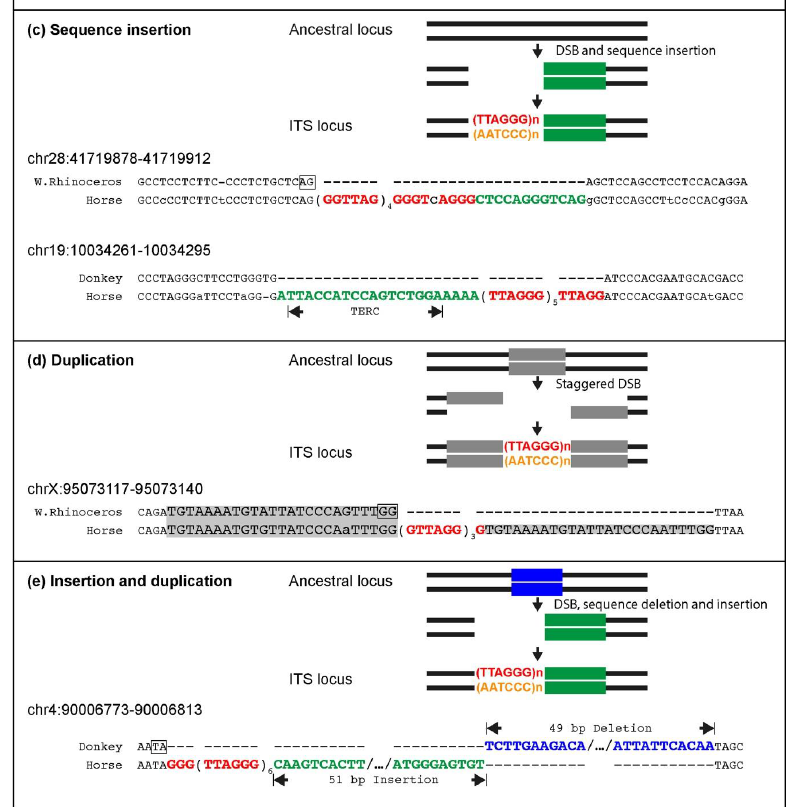
Figure 3. Examples of data used to describe the insertion mechanism of telomeric repeats. For each locus, the alignment of the empty ancestral sequence from donkey or white rhinoceros with the ITS sequence in the horse reference genome assembly is shown. A sketch of the mechanism responsible for telomeric repeat insertion is shown on top of each sequence alignment. Telomeric repeats in TTAGGG and CCCTAA orientation are indicated in red and orange, respectively. At empty loci, nucleotides in register with the inserted telomeric repeats are boxed. ( a ) Interstitial telomeric repeat insertion occurred without modification of the sequences flanking the double-strand break. The orthologous locus from donkey is empty at the insertion site. The double-strand break exposed a GGG trinucleotide in register with the inserted telomeric repeats. ( b ) Interstitial telomeric repeat insertion accompanied by the deletion of nucleotides from the flanking sequence (blue nucleotides, blue strip in sketch). The double-strand break exposed a GGT trinucleotide in register with the inserted telomeric repeats. ( c ) Interstitial telomeric repeat insertion accompanied by the addition of a nucleotide sequence (green nucleotides, green strip in sketch). Telomeric repeat insertion was accompanied by the addition of a random nucleotide sequence, and the double-strand break exposed an AG dinucleotide in register with the inserted telomeric repeats. The ITS was inserted together with 17 bp homologous to a region of horse TERC 91 nucleotides away from the telomeric repeat template. ( d ) Interstitial telomeric repeat insertion at a staggered double-strand break followed by flanking sequence duplication (nucleotides shaded in grey, grey strip in sketch). The double-strand break exposed a GG dinucleotide in register with the inserted telomeric repeats. ( e ) Interstitial telomeric repeat insertion accompanied by a complex modification of the insertion site involving the simultaneous deletion of nucleotides and addition of a random sequence. A TA dinucleotide in register with the inserted telomeric repeats was exposed by the double-strand